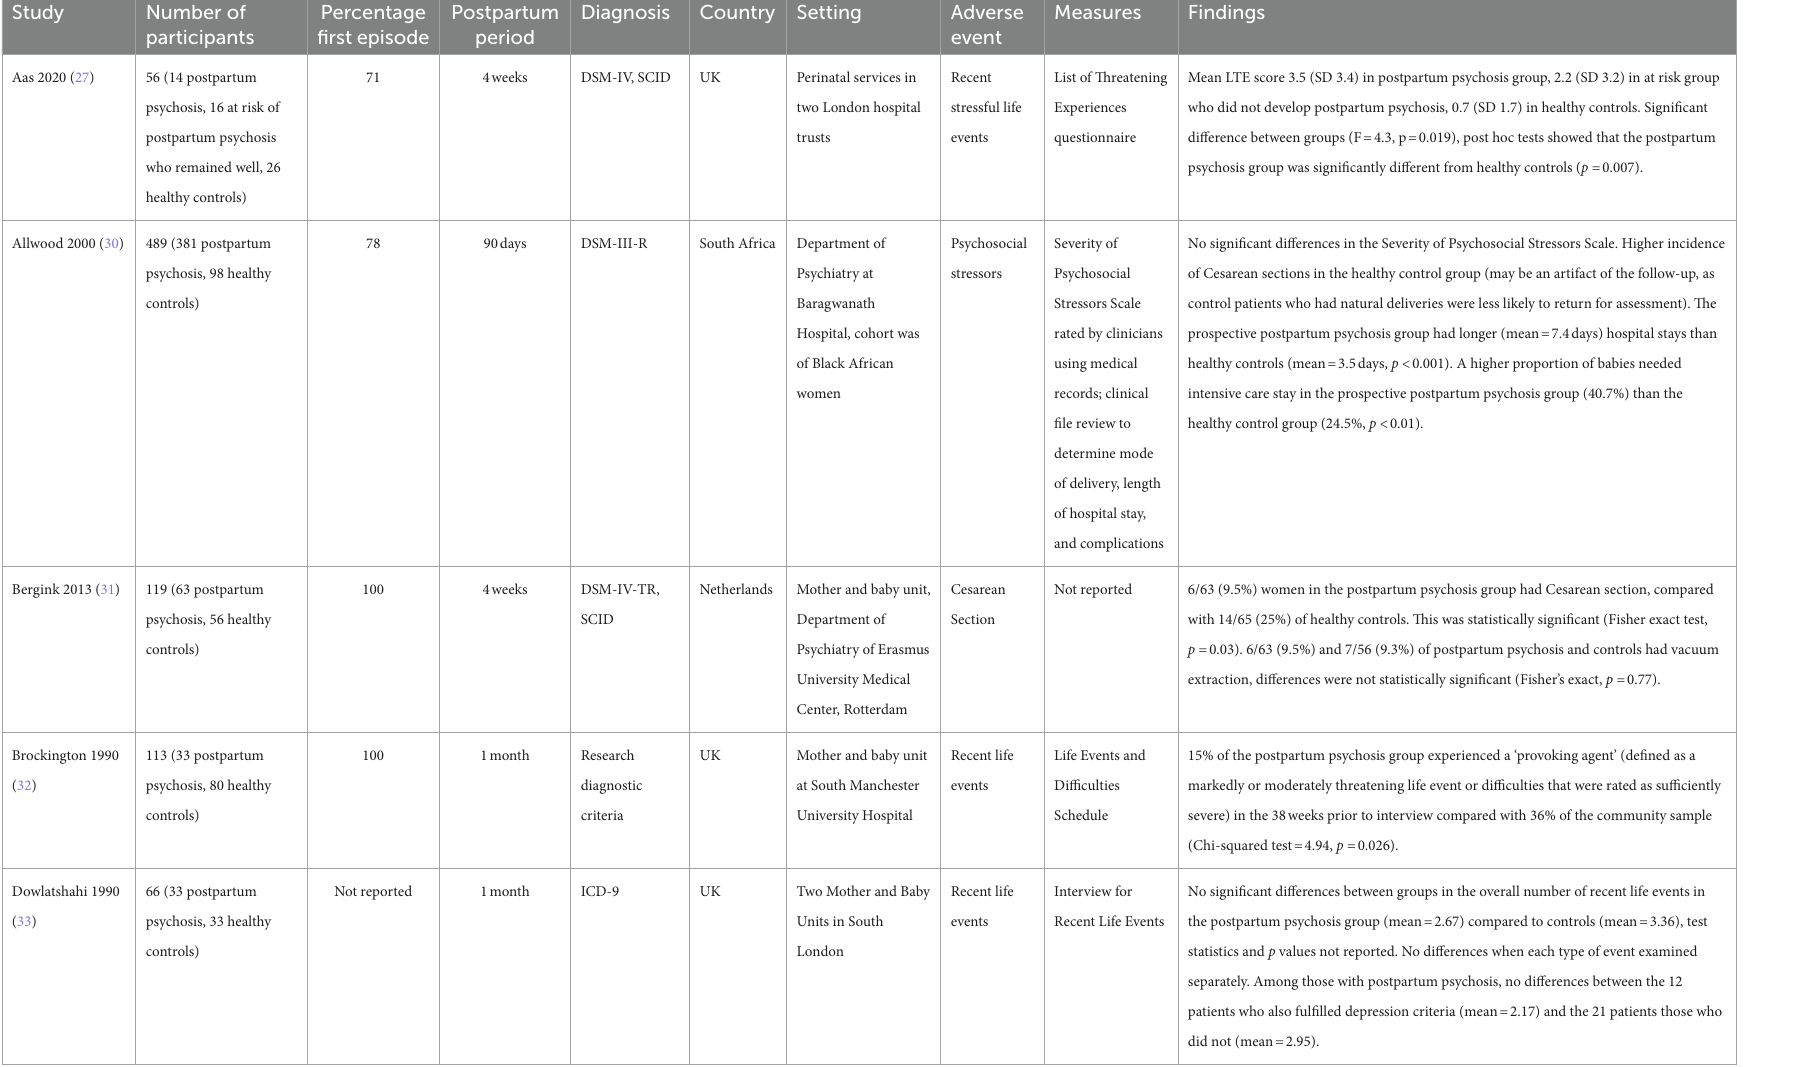
Mean LTE score 3.5 (SD 3.4) in postpartum psychosis group, 2.2 (SD 3.2) in at risk group who did not develop postpartum psychosis, 0.7 (SD 1.7) in healthy controls. Significant questionnaire difference between groups (F = 4.3, p = 0.019), post hoc tests showed that the postpartum psychosis group was significantly different from healthy controls ( p = 0.007).